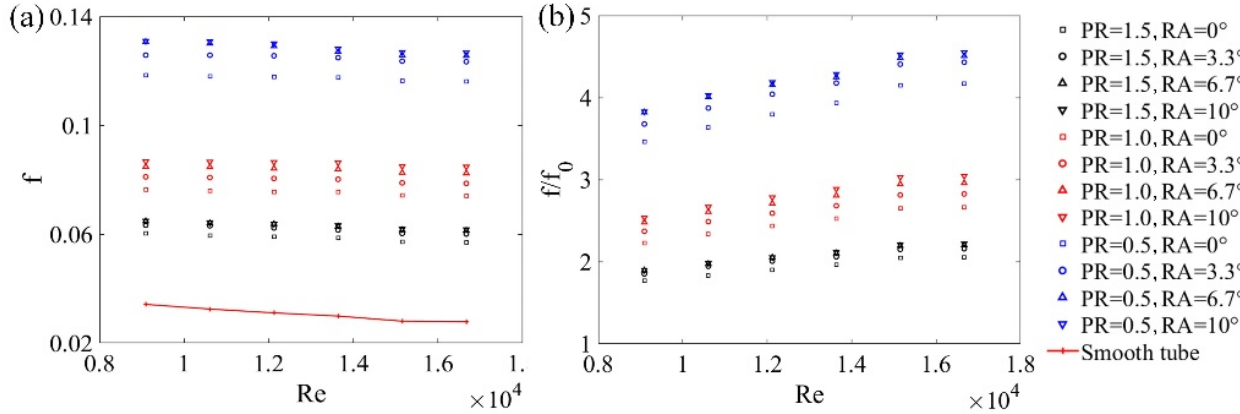
Figure 10. Effects of vortex generators on the f for different PR s and RA s. ( a ) the relationship between Re and f with different PR s and RA s; ( b ) the relationship between the friction efficient ratio f / f 0 and Re with different PR s and RA s.